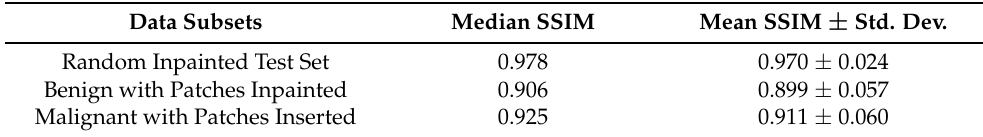
Figure 4. Differences for P ( malignant | x ) before and after inpainting a random segment in test images without a coloured patch. Table 2. Structural Similarity Index Measure (SSIM) between the altered images and their original versions. A value closer to 1 indicates that the images are more